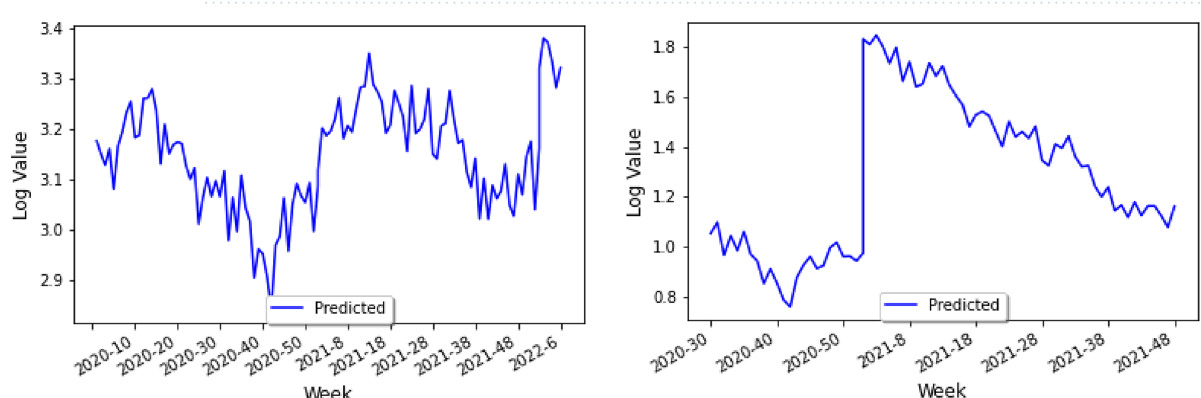
Figure 20. Predicting Cambodia’s dengue cases using Peru as the training set (left), and using both Peru and Brazil’s data as training set